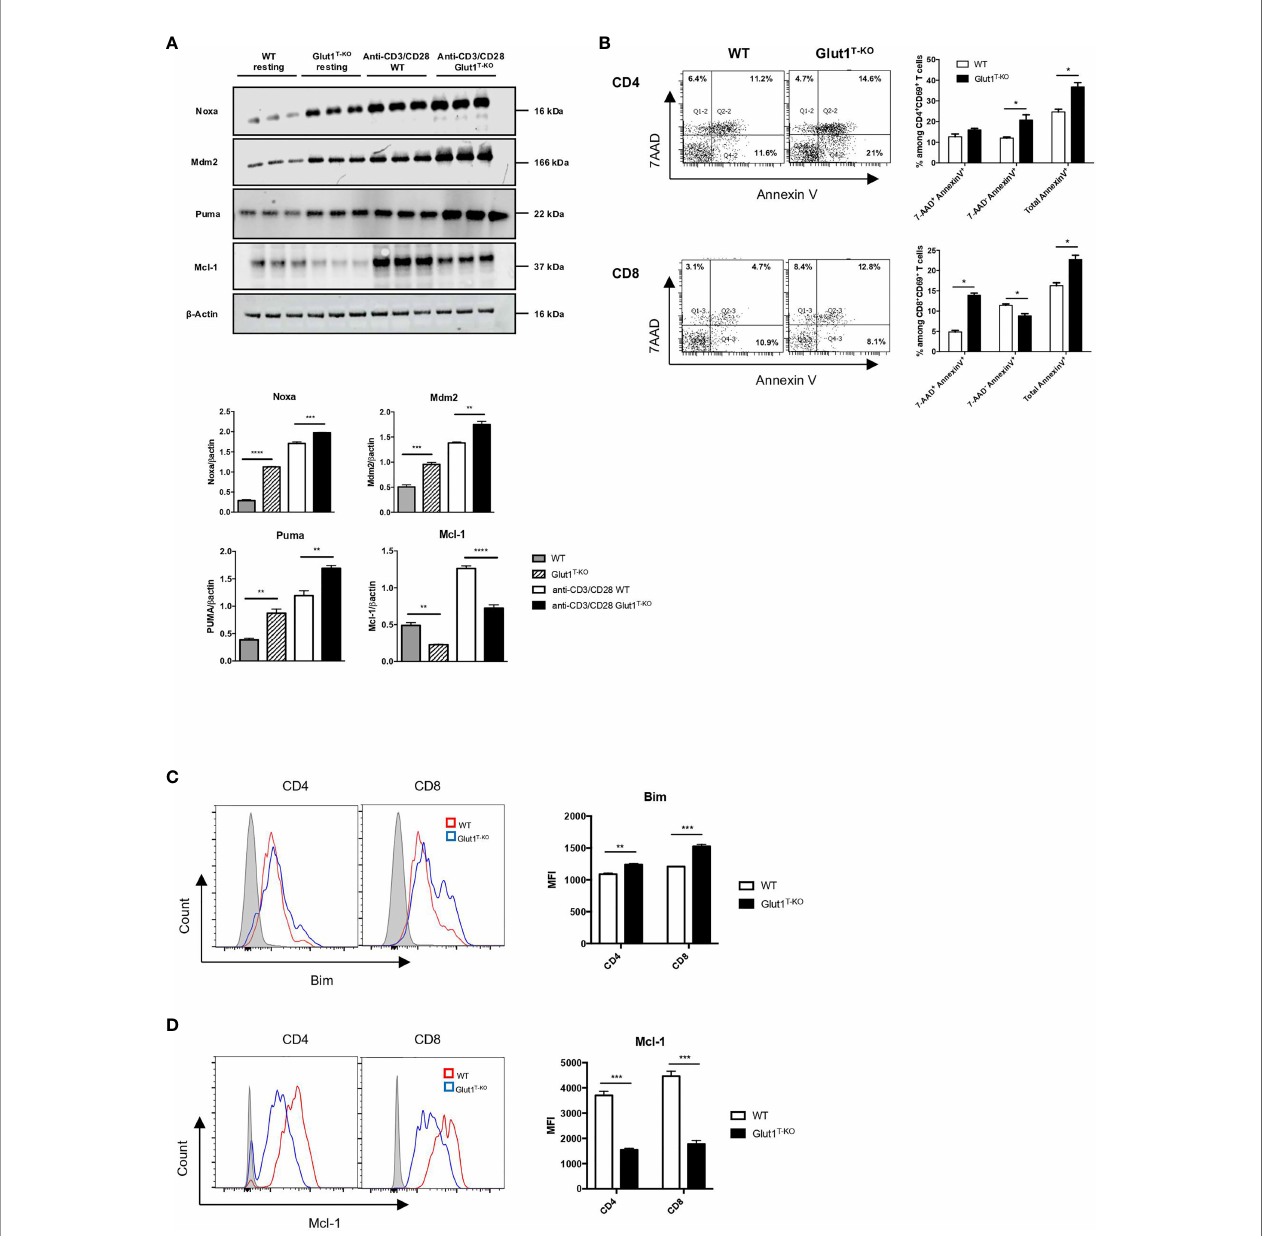
FIGURE 3 | Glut1 modulates alloreactive T cell survival. (A) Freshly isolated WT or Glut1 T-KO T cells or those stimulated with anti-CD3 (1ug/ml) and anti-CD28 (0.3ug/ml) antibodies for 16 hours were assessed for the expression of Mdm2, Puma, Noxa, and Mcl-1 using Western blotting (upper panel). Results were quanti fi ed for fresh T cells and antibody-stimulated T cells (lower panel) (n = 3, one-way ANOVA with a Tukey ’ s multiple comparisons test). (B) WT or Glut1 T-KO T cells were stimulated for 16 hours by irradiated (20 Gy) BALB/c DCs and analyzed by fl ow cytometry for Annexin V and 7AAD. T cells were gated on CD69 + CD4 + or CD8 + T cells. Bim (C) and Mcl-1 (D) expression were evaluated. Data are representative of three experiments (n = 3) and are shown as mean ± SEM. *P < 0.05, **P < 0.01, ***P < 0.001, ****P < 0.0001, 2-tailed Student t